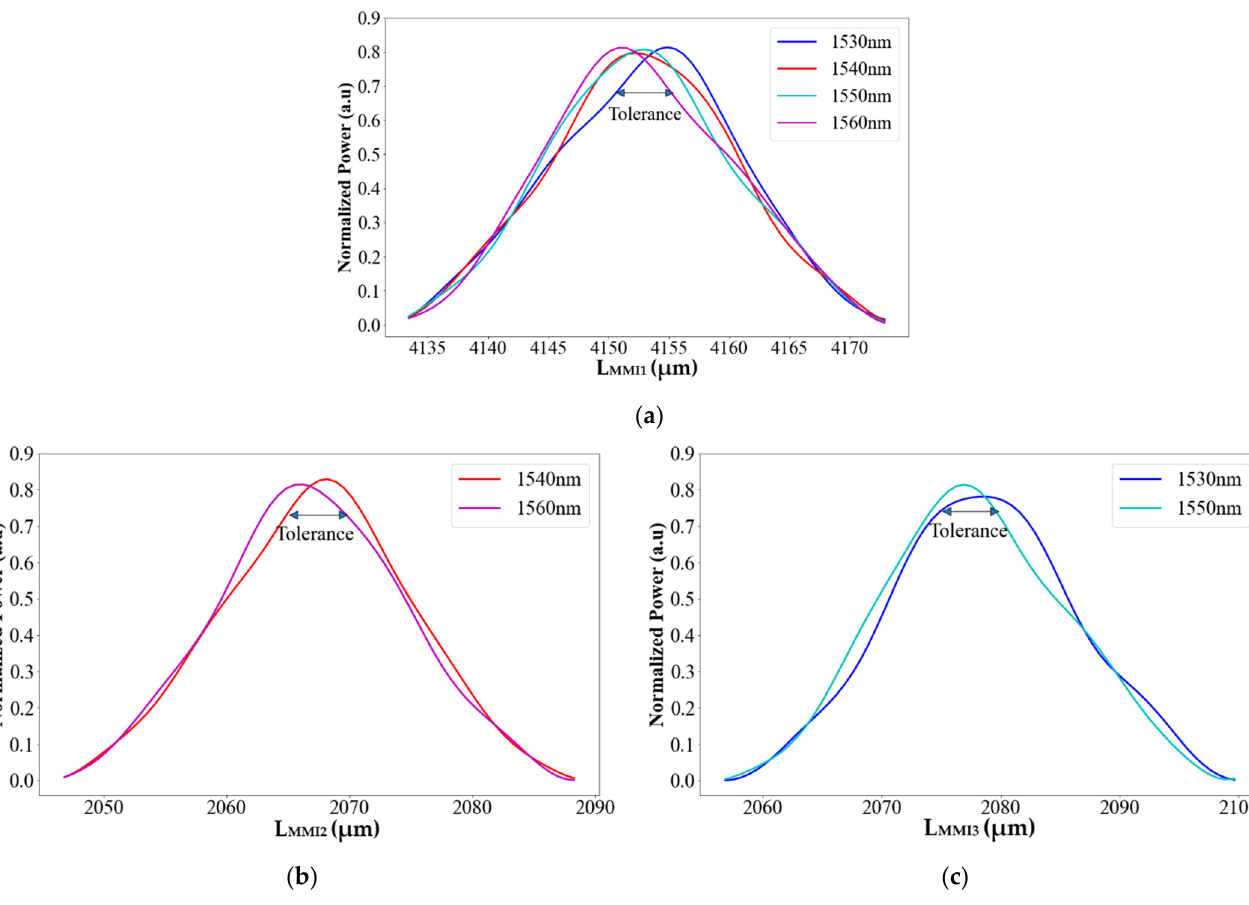
Figure 5. Normalized power as a function of ( a ) L MMI1 , ( b ) L MMI2 , and ( c ) L MMI3 .